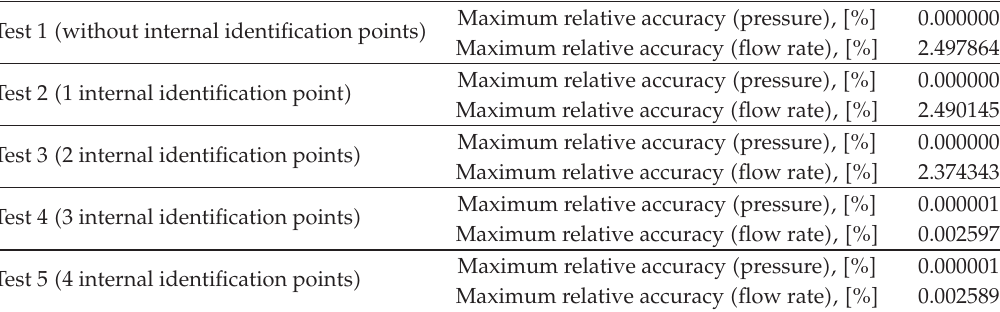
Table 7: The results after Stage 2 of the test simulation.